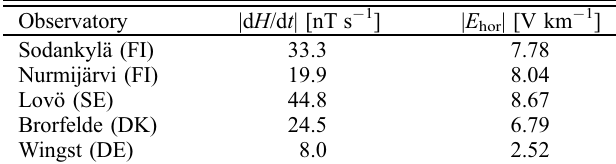
Table 5. Maximum time derivative of the 1-min horizontal magnetic field and maximum horizontal electric field on 13–14 July 1982 at a few observatories listed from the north to south. The ground conductivity model of block 24 in Table 2 has been